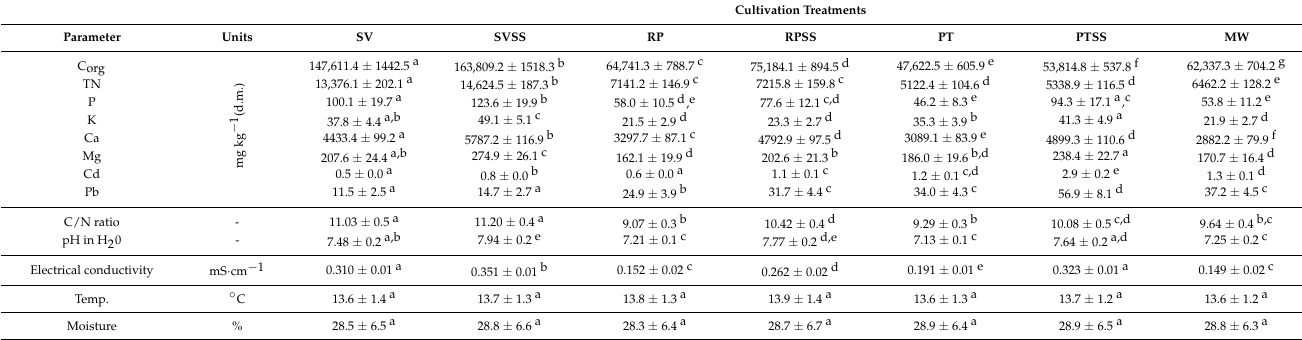
Table 1. Content of macro-nutrients and trace elements in the given cultivation treatment soils (mean ± standard deviation based on five